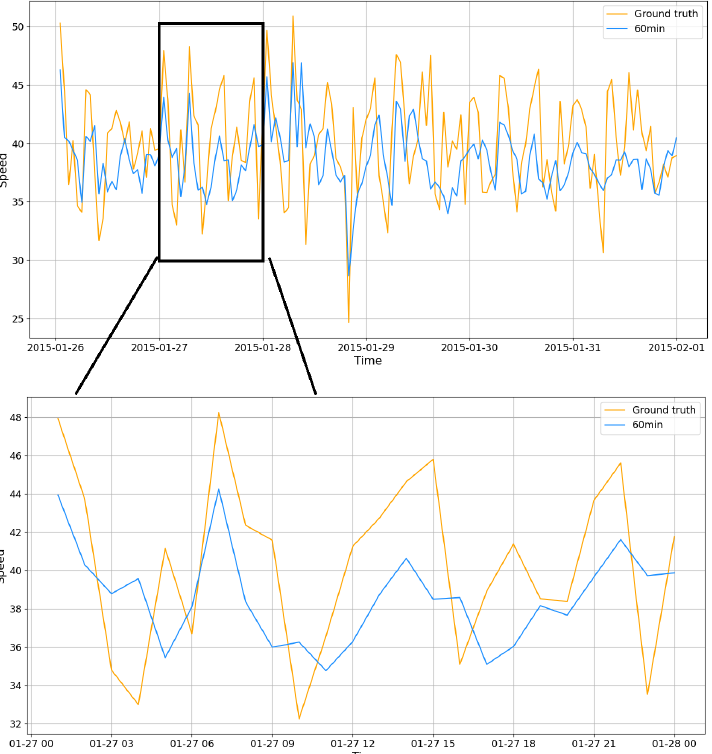
Figure 10. Result for prediction horizon of 60